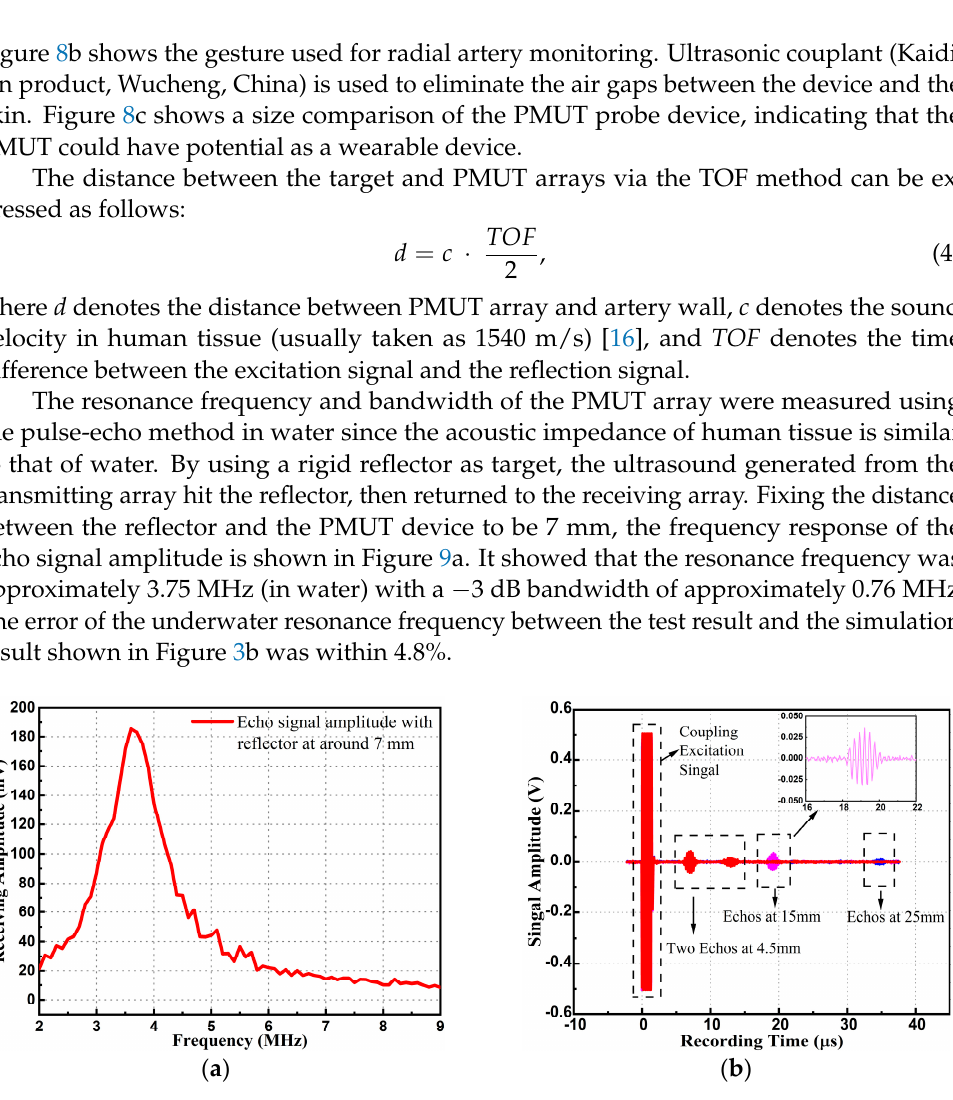
Figure 9. ( a ) Frequency response of underwater acoustic pulse-echo signals. ( b ) Pulse-echo signals with reflector at resonance frequency with three different detection distance.